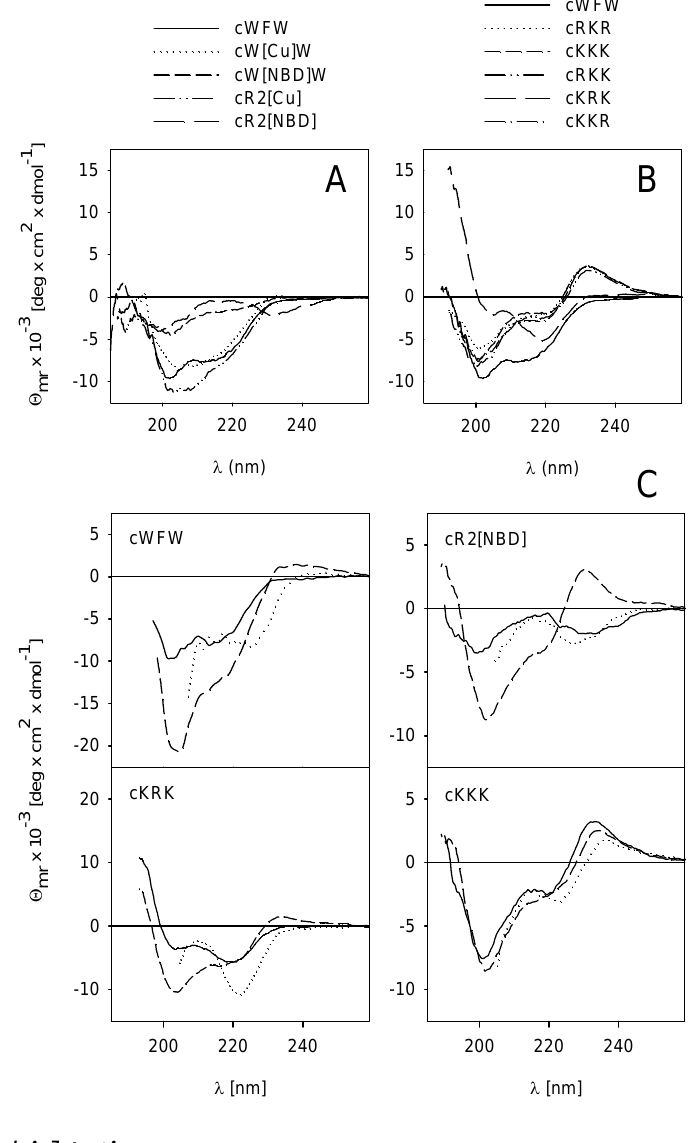
Figure 3. CD spectra of the cyclic hexapeptides in different solvent systems. ( A ) Lysine-substituted and ( B ) fluorescent-labeled peptides compared to cWFW in phosphate buffer. The effect of membrane-mimicking additives on the structure of selected lysine peptides is shown in ( C ): phosphate buffer (solid lines), 25 mM SDS (dashed lines) and 10 mM POPG-SUVs (dotted lines). Peptide concentration was 100